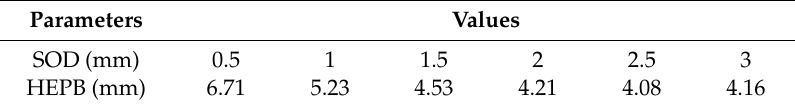
Table 1. HEPB varying with SOD.